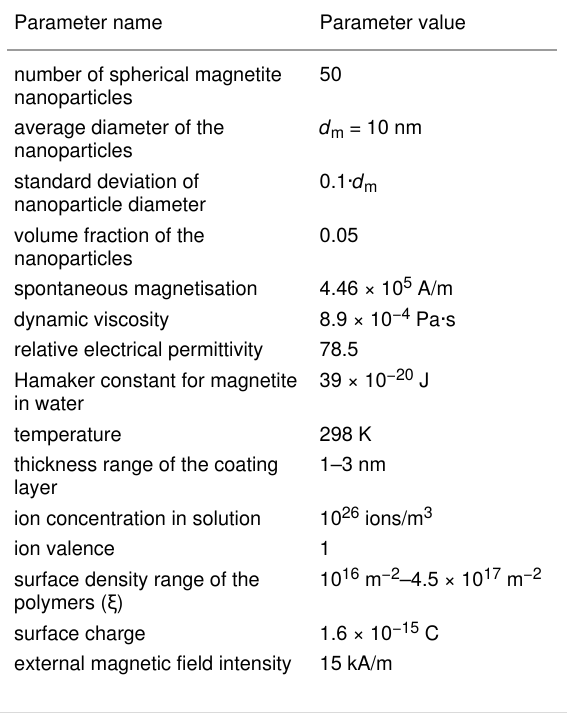
Table 1: The values of the parameters involved in the